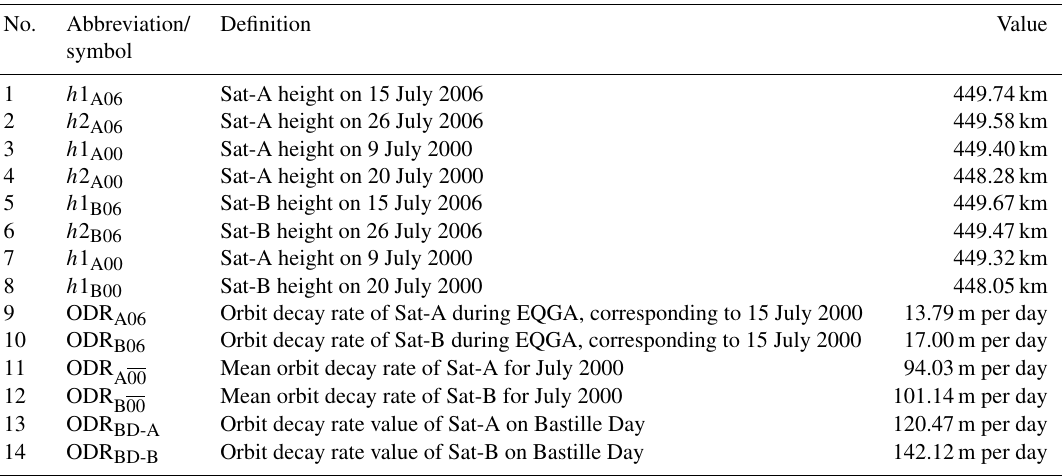
Table 3. Indices used for description effects of the 12d intervals of elevated and exceptionally quiet geomagnetic activity (9–20 July 2000 and 15–26 July 2006). Note: EQGA – exceptionally quiet geomagnetic activity.